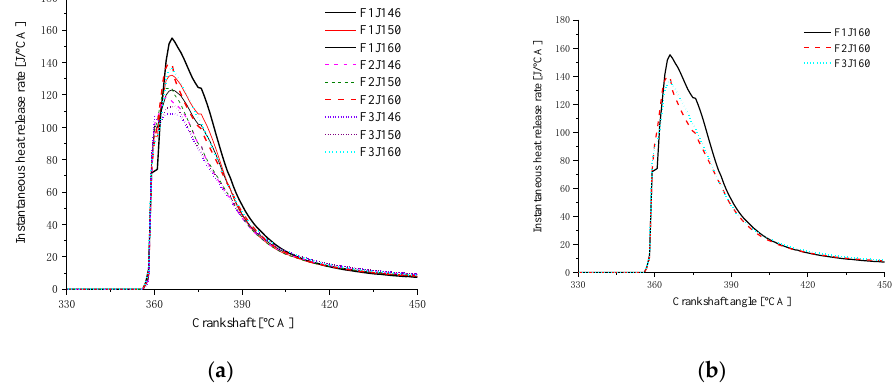
Figure 13. Comparison of the in-cylinder pressure between three combustion chambers combined with different spray angles. ( a ) Three chambers combined with spray angles of 160°, 150° and 145°; ( b ) Three chambers combined with a spray angle of 160°.